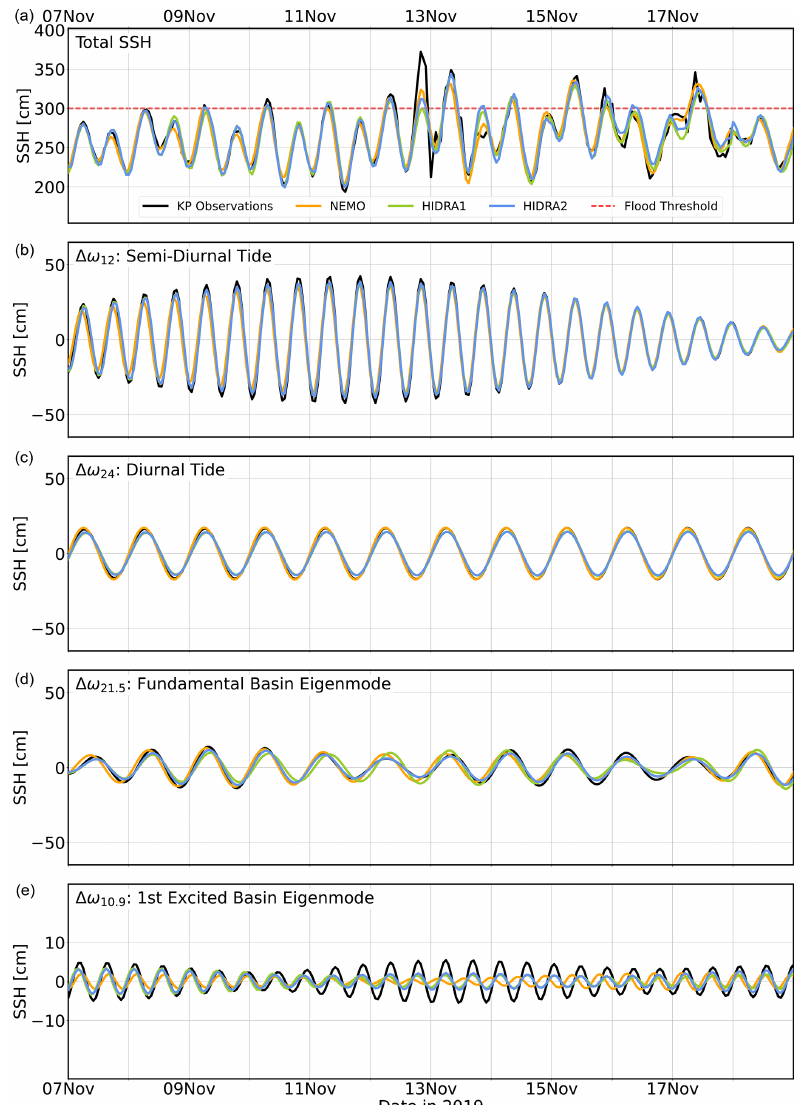
Figure 15. Comparison of total Koper SSH observations and forecasts (a) and their band-pass-filtered signals (b–e) over four bands, centered around four geophysically relevant periods (semi-diurnal and diurnal tides and the two lowest along-axis basin eigenmodes). The time window of the SSH signal spans from 7 November 2019 to 19 November 2019. Note the different vertical scale in (e)